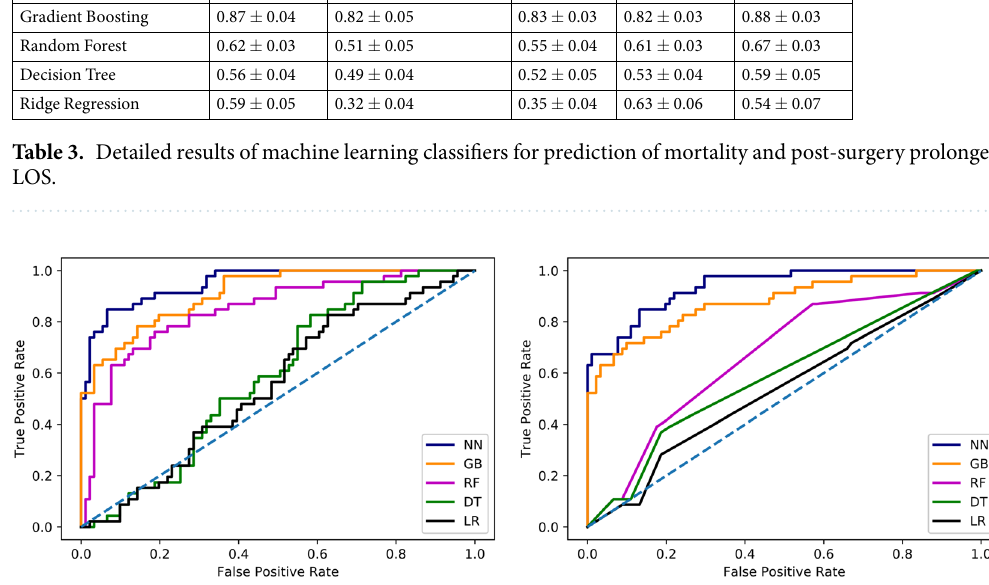
Figure 3. ROC curves afor each machine learning model after testing using all of the 50 MCMC MI datasets. (left) Risk of mortality prediction (right) Prolonged LOS